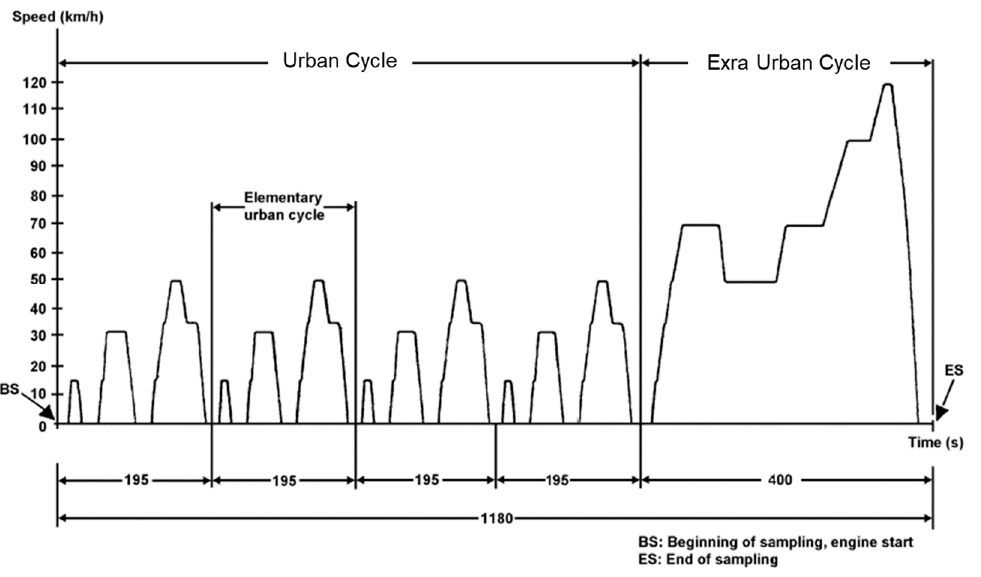
Figure 2. New European Driving Cycle (NEDC) test cycle.